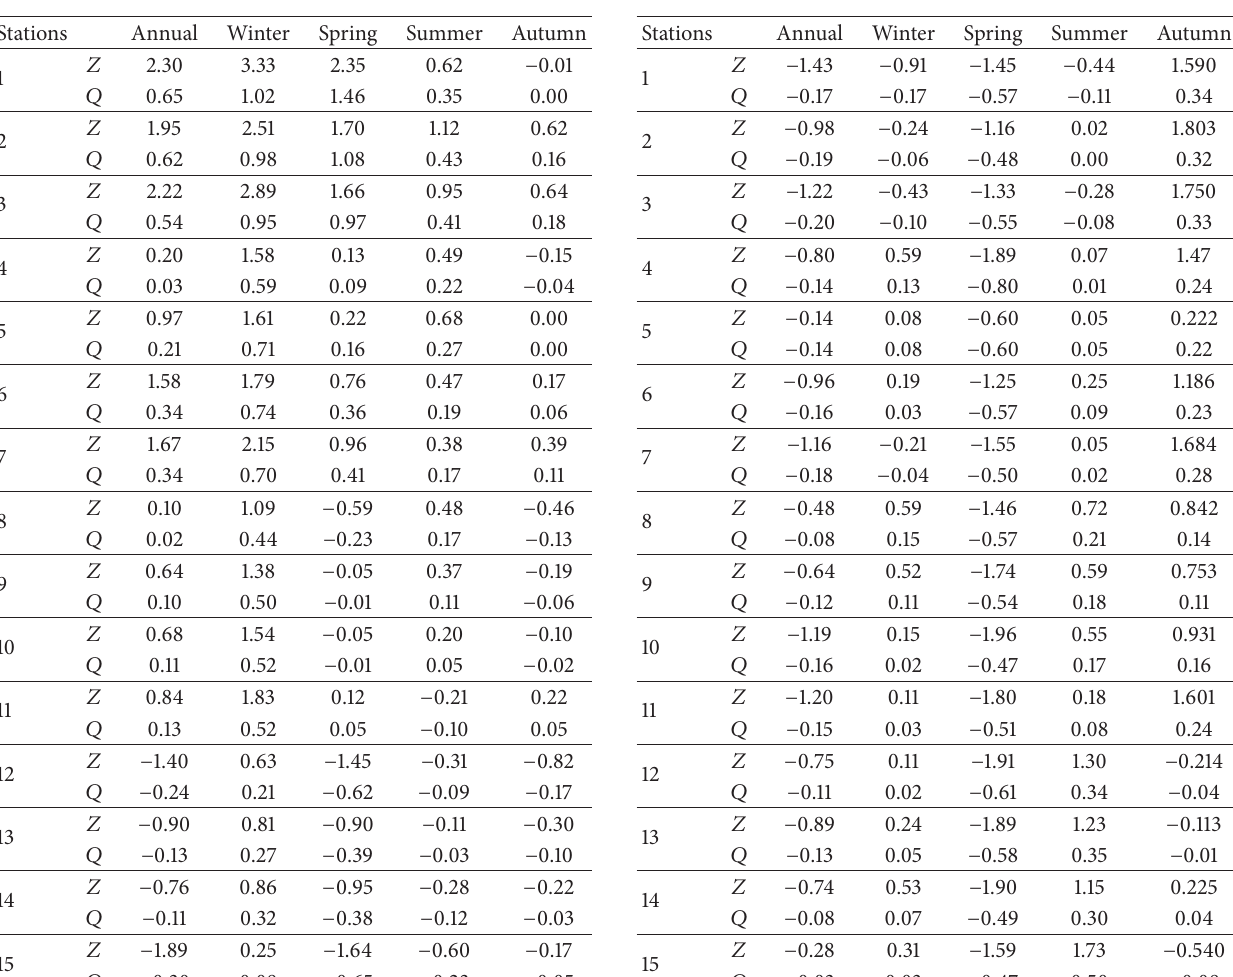
Table 3: Mann Kendall and TSA results of precipitation during the period of 1901–1960.